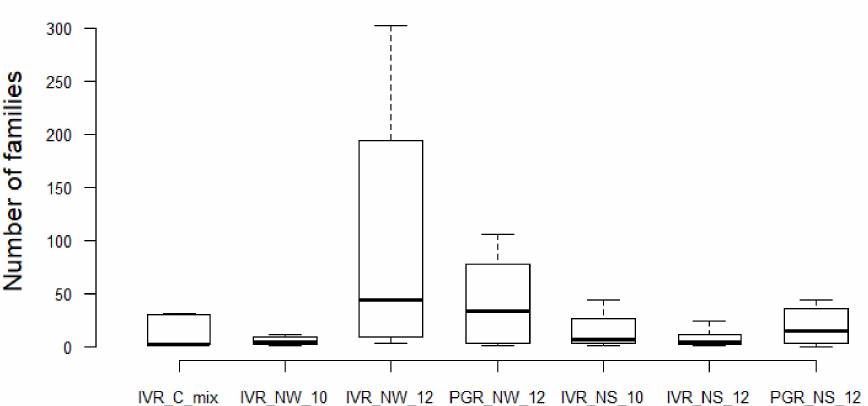
Figure 5. Boxplots illustrate the variation of bacterial families among samples from different ge- ographical locations, seasons, and matrix types. The boxes show the 25–75 percentile values; the horizontal bars indicate the median, and the whiskers indicate the minimum and maximum data points. Mixed cultures (Isla Verde Reef) = IVR-C-Mix; Water column (IVR) = IVR-NW-10 (September 2010); IVR-NW-12 (March 2012); Water Column (Punta Gorda Reef) = PGR-NW-12 (May 2012); Natural sediment (Isla Verde Reef) = IVR-NS-10 (September 2010); IVR-NS-12 (March 2012); Natural sediment Punta Gorda Reef = PGR-NS-12 (May